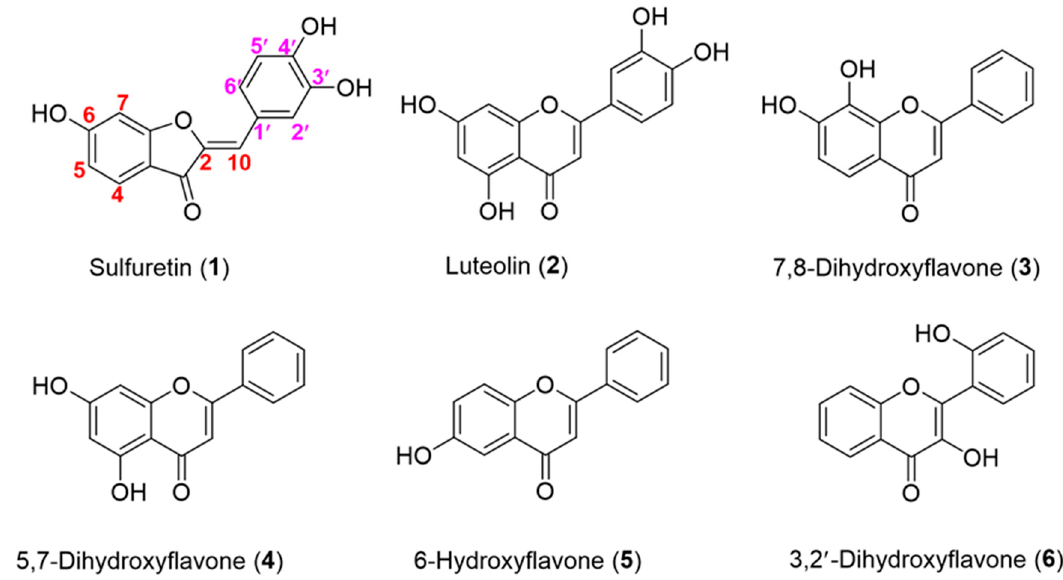
Figure 2. The detailed structures of 6 reactive substrates of OsUGT1.